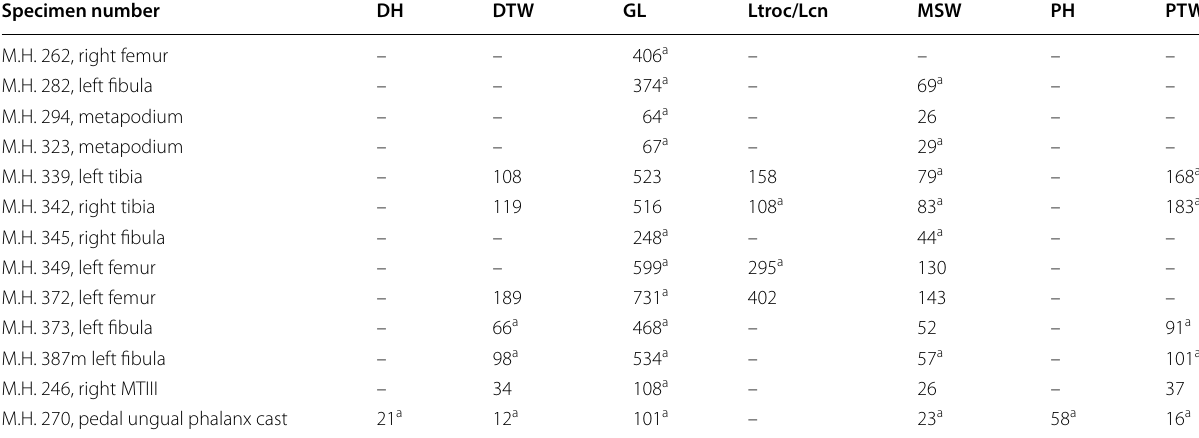
DH distal height (applies only to ungual phalanges), DTW distal transverse breadth, GL greatest length, Ltroc/Lcn distance from distal end to 4th trochanter (applies ony to femur)/length of cnemial crest (applies only to tibia), MSW minimum shaft width, PH proximal height (applies only to ungual phalanges), PTW proximal transverse breadth. All measurement are in mm a Indicates that the measurements refers only to preserved dimension at the incomplete bone